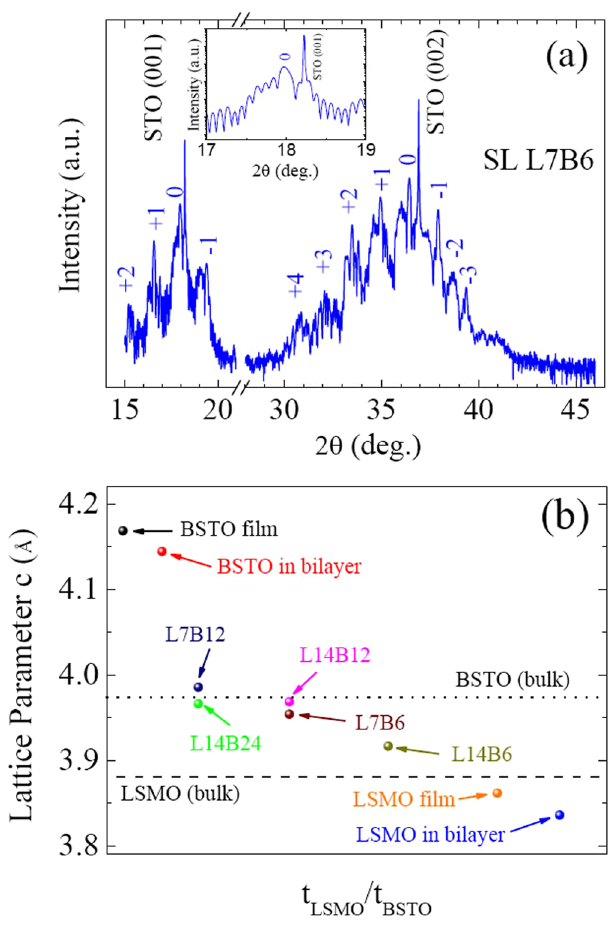
Figure 1. ( a ) SXRD θ -2 θ scan curve of the SL L7B6. The numbers 1, 2, 3, … indicate the order of the satellite peaks. ( b ) The out-of-plane lattice parameter c of the superlattices, bilayer, thin films with the thicknesses of the LSMO and BSTO layers. The dished and dotted lines represent the c -axis lattice parameter of bulk LSMO and BSTO, respectively. Inset in ( a ) shows Pendellösung fringes around (001) diffraction peak of